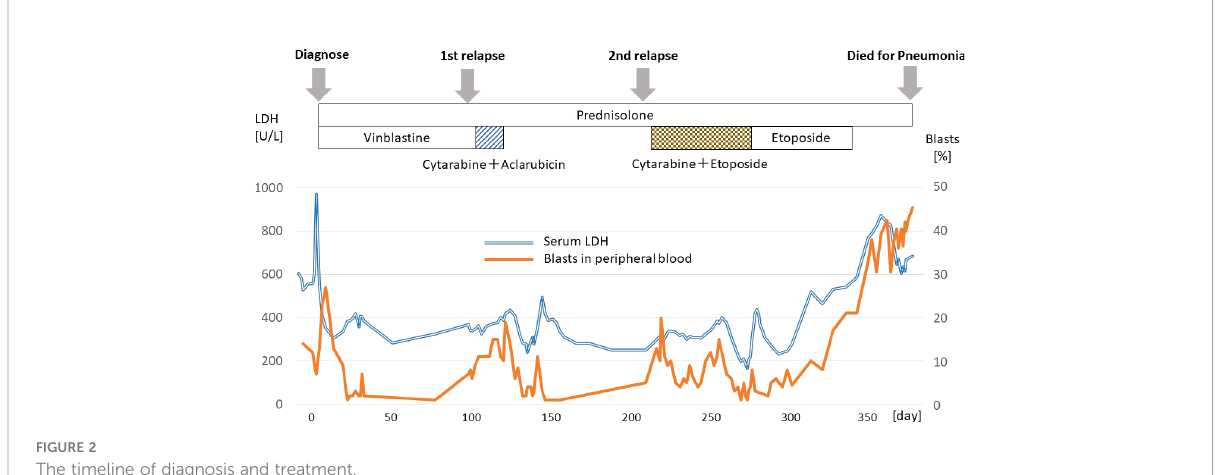
FIGURE 2 The timeline of diagnosis and treatment.